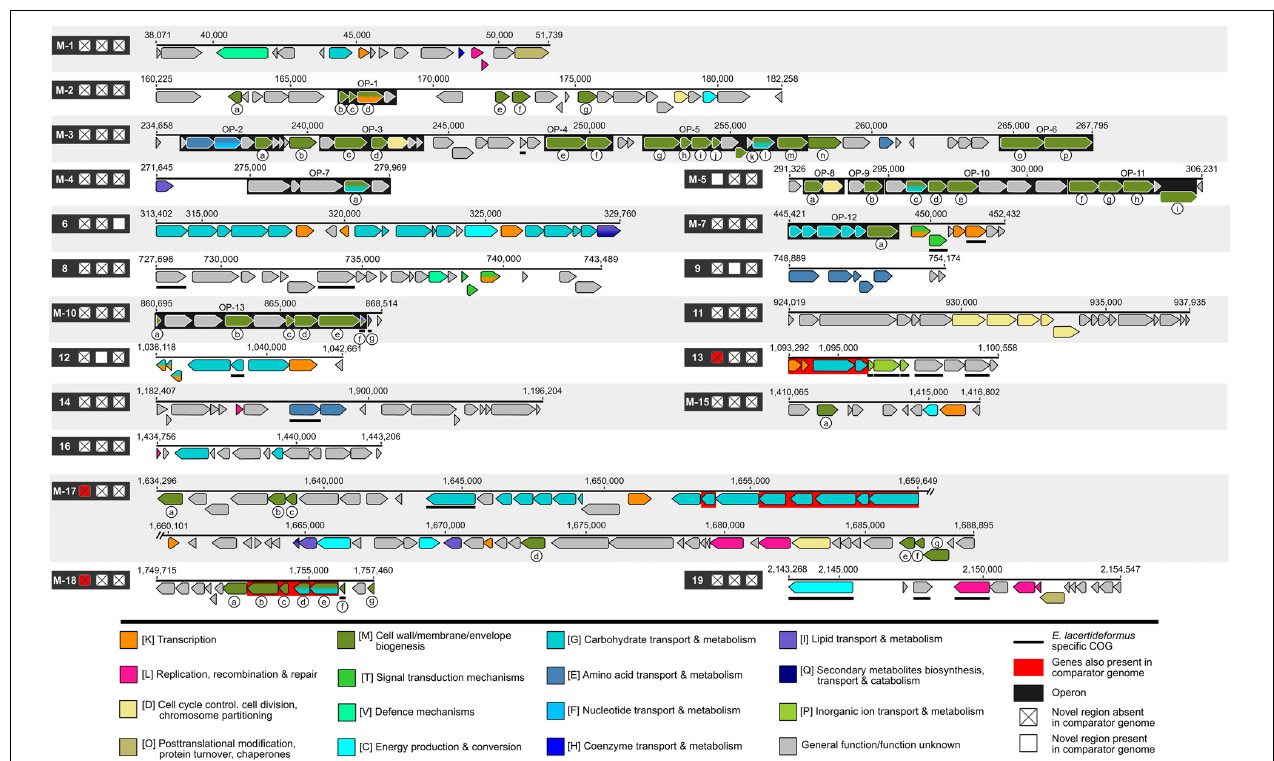
FIGURE 4 | Regions unique to E. lacertideformus. The unique regions present in the E. lacertideformus whole genome scaffold and absent in at least two of the comparator genomes E. villorum, E. hirae and E. faecium are illustrated. Individual regions unique to E. lacertideformus are numbered (1–19) according to their order in the genome. Boxes adjacent to numbered regions indicate the presence and/or absence of the specific region in comparator genomes. Boxes from left to right refer to E. villorum F1129D , E. hirae R17 and E. faecium AUS0085, respectively. Boxes marked [X] indicate that the novel region displayed is absent in a particular comparator genome. Genes are colored according to their classification into different COG functional categories. Genes encoding the cell wall/membrane/envelope biogenesis [M] feature are alphabetically labeled for further reference to tabulated data describing gene functionality ( Supplementary Table 11 ). Clusters of genes within a unique region highlighted in red refer to genes also present in a particular comparator genome (check box also marked red). Numbers above the genes indicate nucleotide positions.